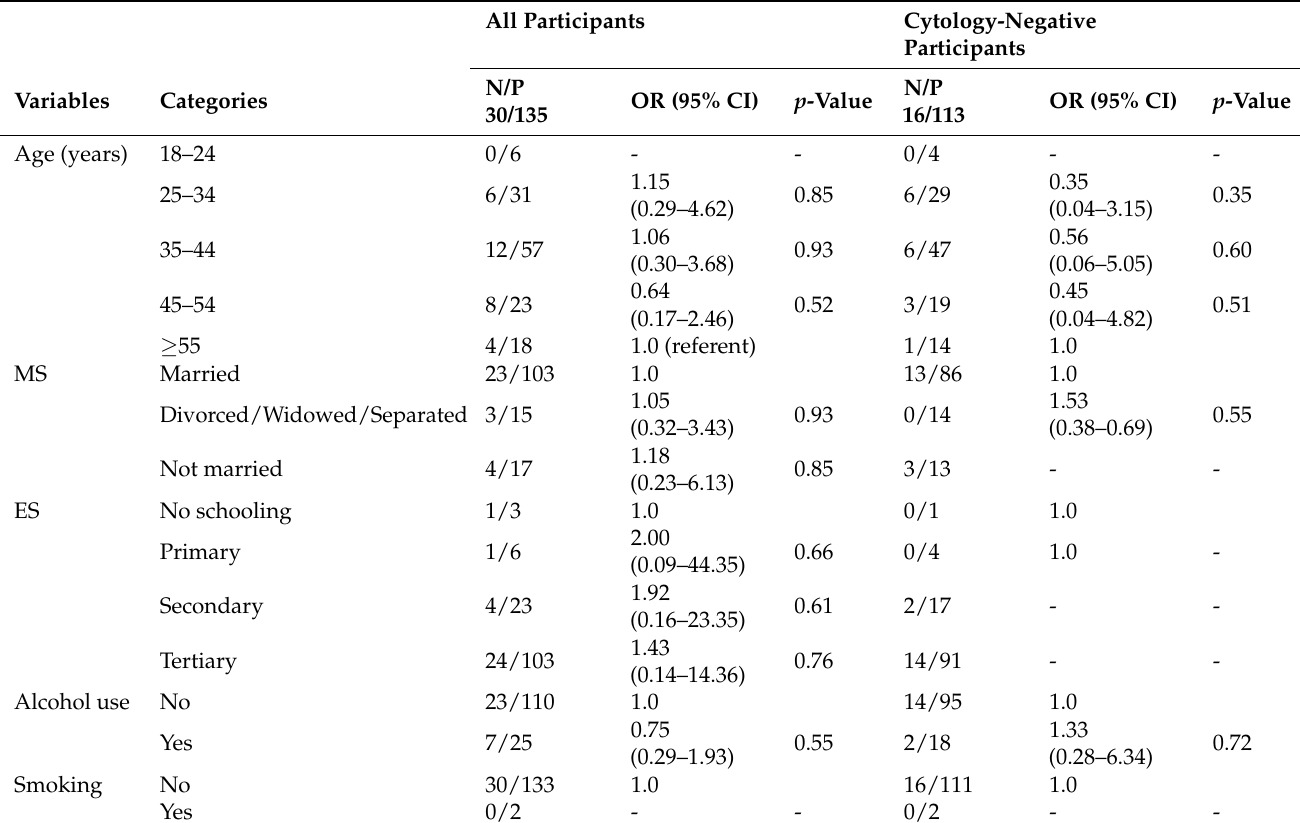
Table 1. Odds ratios of HPV positivity according to sociodemographic variables. All Participants